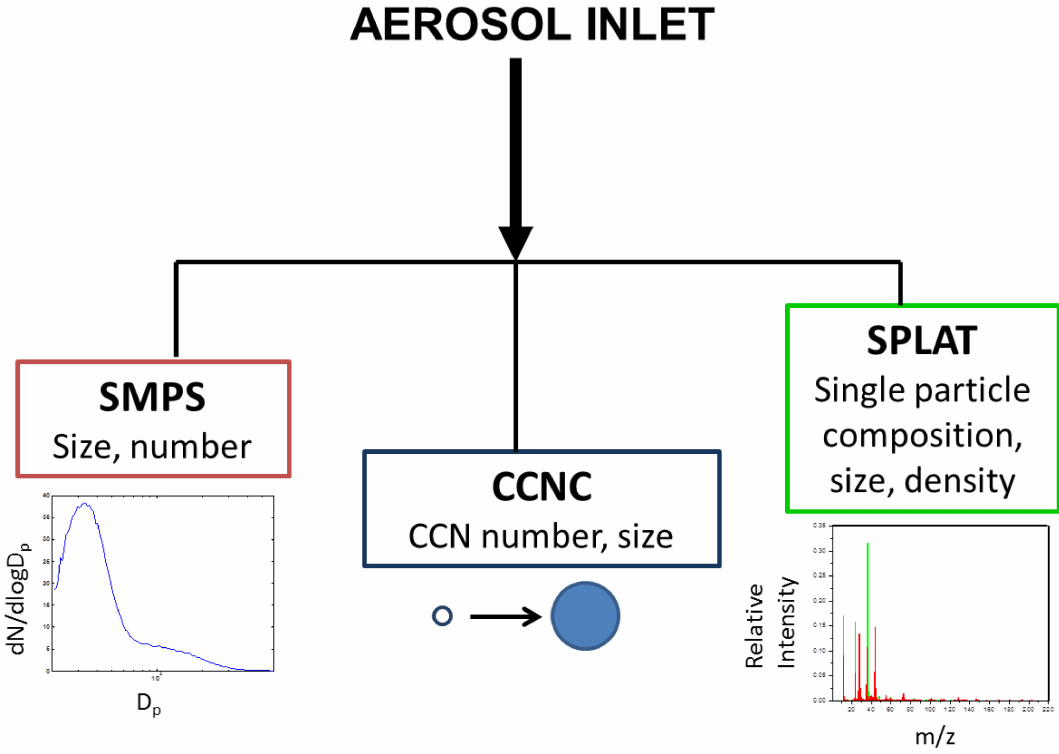
Fig. 1. Schematic of experimental setup used at SPL. Aerosol size and number concentrations were measured by a scanning mobility particle sizer (SMPS), droplet activation and resulting droplet number concentrations as a function of chamber supersaturation were assessed by a Cloud Condensation Nuclei Counter (CCNC), and single particle mass spectrometer (SPLAT II) measured the composition, size, and density of individual